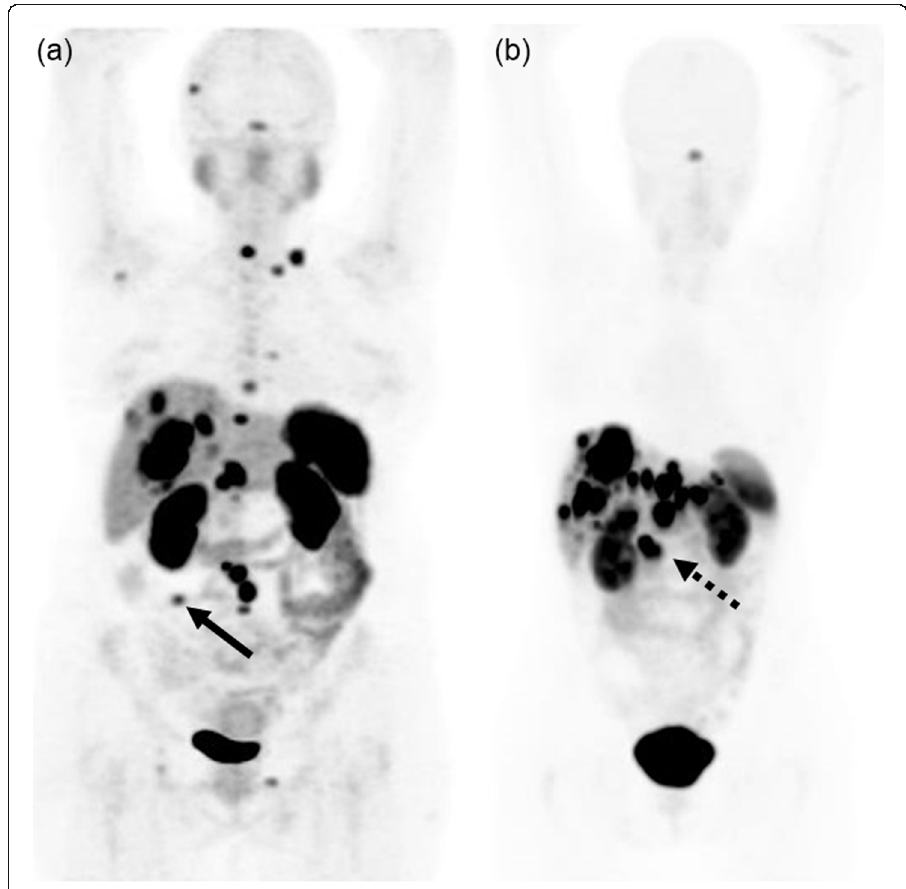
Fig. 2 A 2 [68Ga]Ga-DOTA-TATE PET MIP ( a , b ) images in two female patients, 42-year and 49-year-old, with ectopic ACTH secreting Cushing syndrome due to metastatic neuroendocrine tumors. Primary tumor